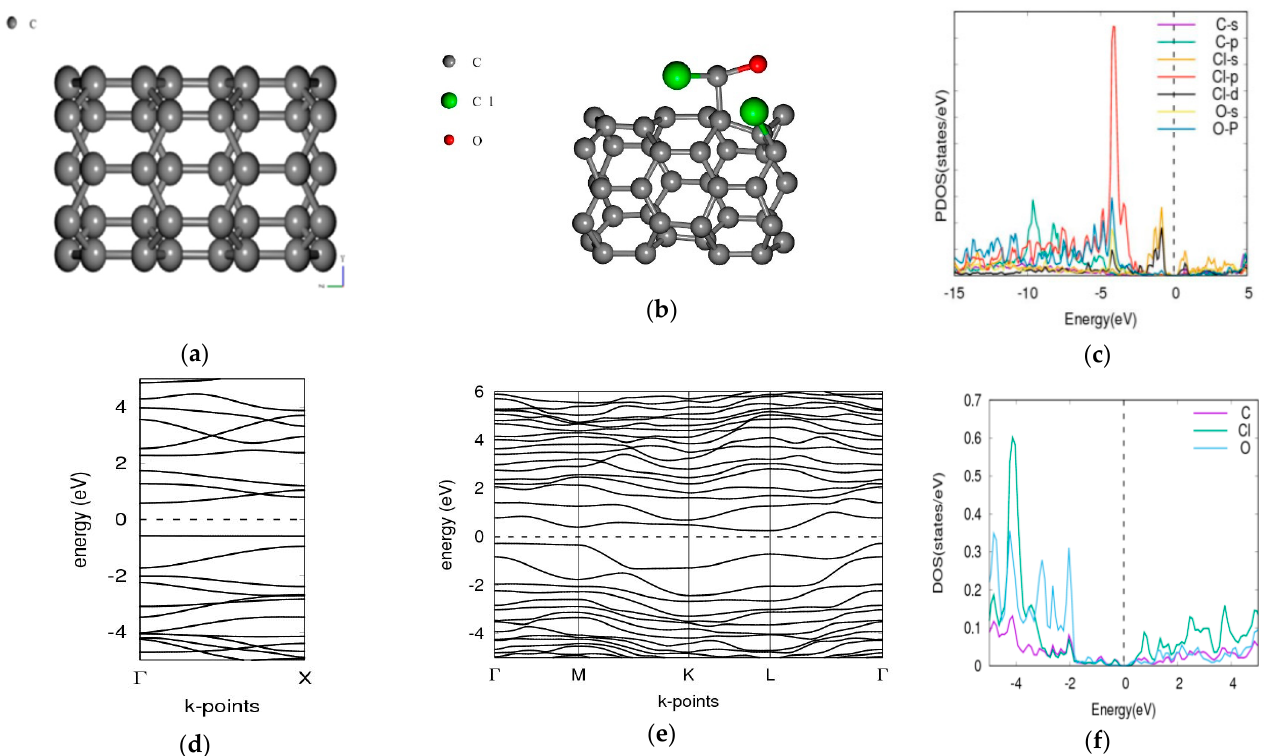
Figure 1. Band structure and density of states for phosgene gas interaction with [5,0] CNT. ( a ) CNT structure Eg = 1.8959 eV, ( b ) phosgene-[5,0]-CNT Eg = 3.1337 eV, ( c ) phosgene-CNT PDOS, ( d ) band structure of CNT, ( e ) band structure of phosgene-CNT, and ( f ) phosgene-CNT DOS.